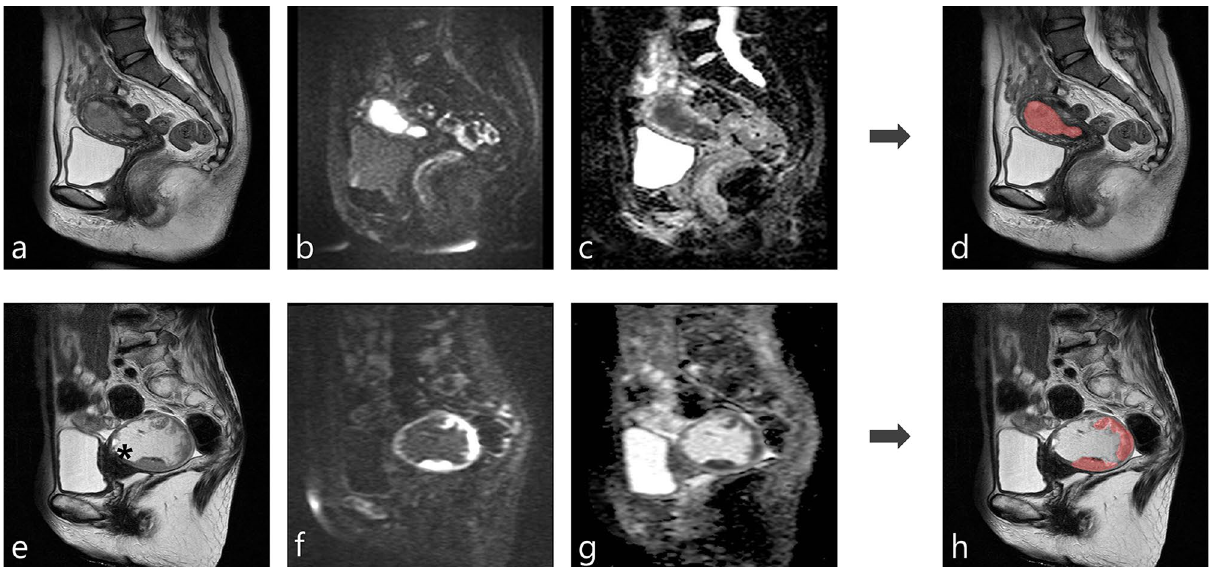
Figure 1. Two representative cases of automatic segmentation. (Case 1: a–d, Case 2: e–h). ( a, e ): T2-weighted image. ( b , f ): Diffusion-weighted image (b = 1000 s/mm 2 ). ( c , g ): Apparent diffusion coefficient map. ( d , h ): Results of automatic segmentation of endometrial cancer overlaid on a T2-weighted image. The tumor was almost perfectly segmented in case 1 (Dice similarity coefficient, 0.925). The tumor was well segmented in case 2, despite the presence of hematometra (e:*) (Dice similarity coefficient,